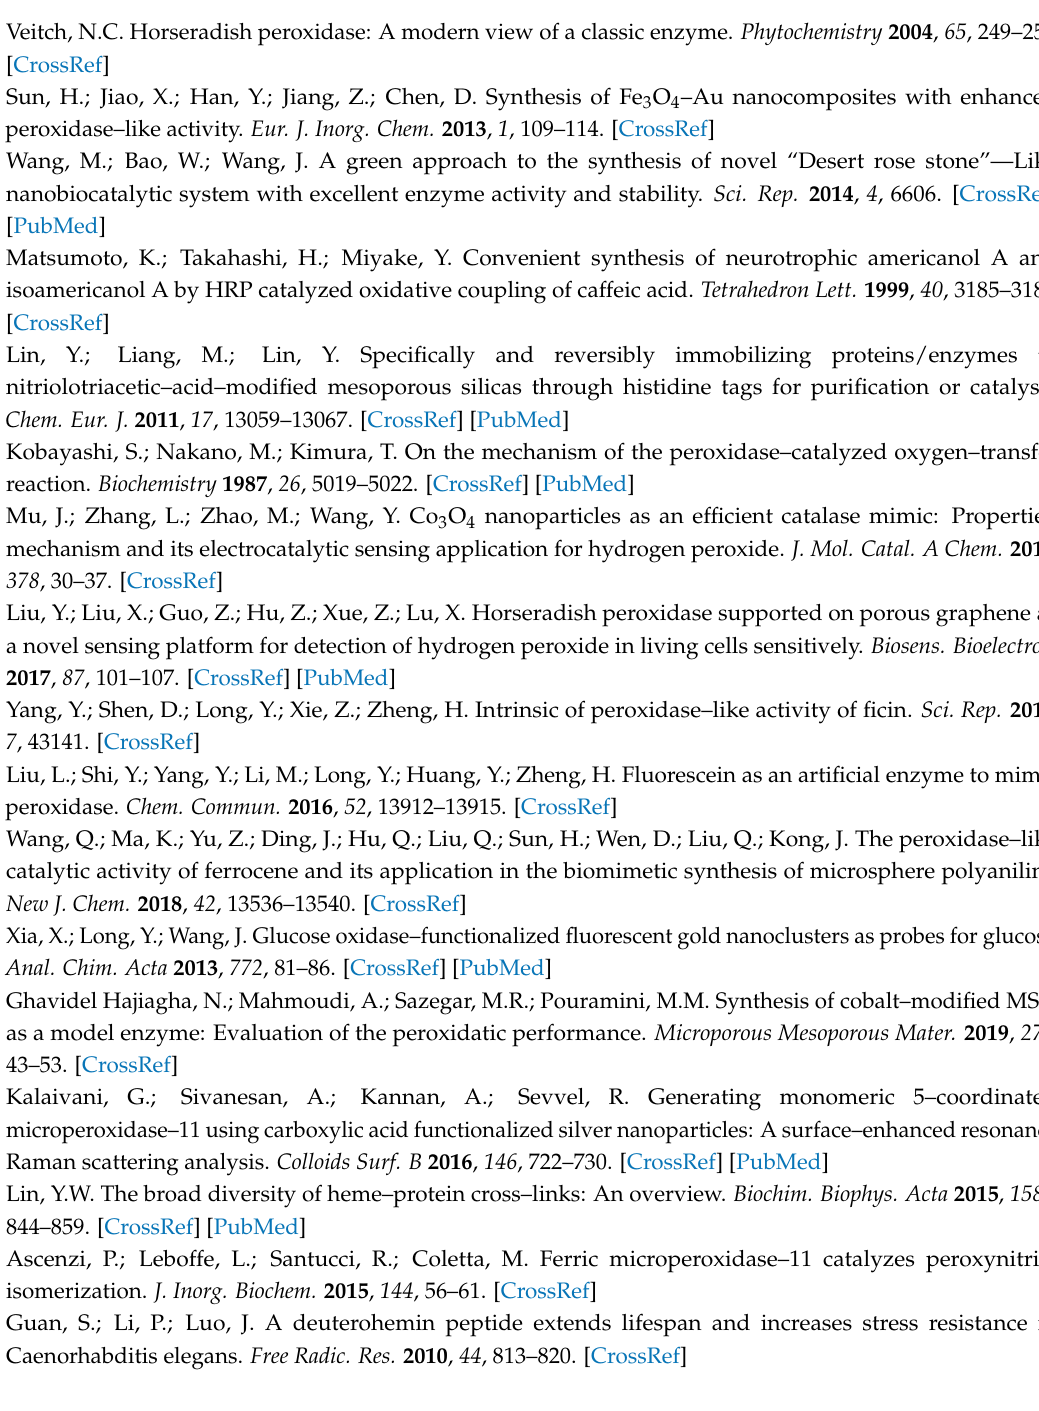
Figure S1: RP–HPLC of Dh–A–H–E; Figure S2: TOF–MS of Dh–A–H–E; Table S1: Comparison of the various mimetic peroxidases for H 2 O 2 detection; Table S2: Comparison of various mimetic peroxidases for glucose